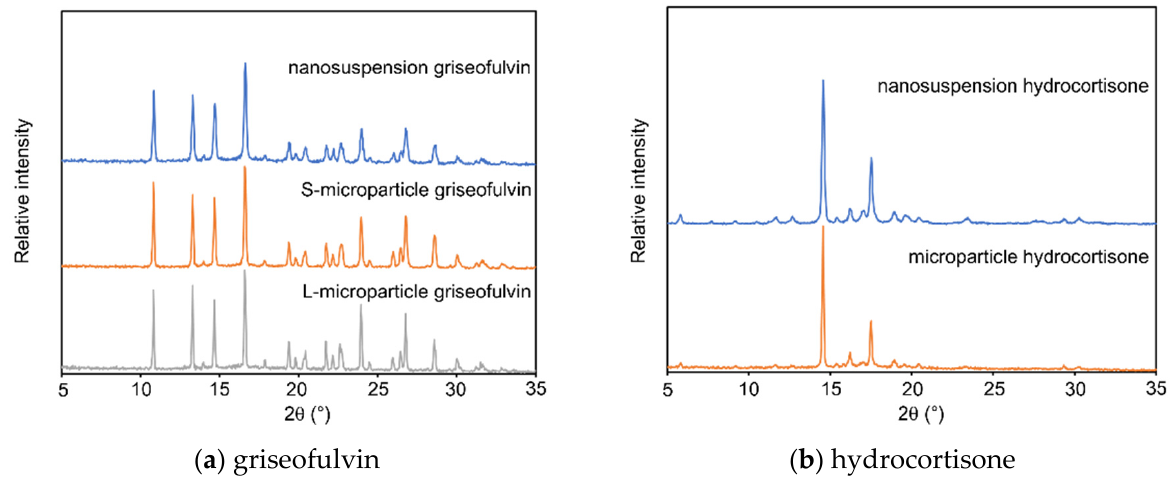
Figure 4. X-ray powder diffraction pattern of: ( a ) griseofulvin samples; ( b ) hydrocortisone